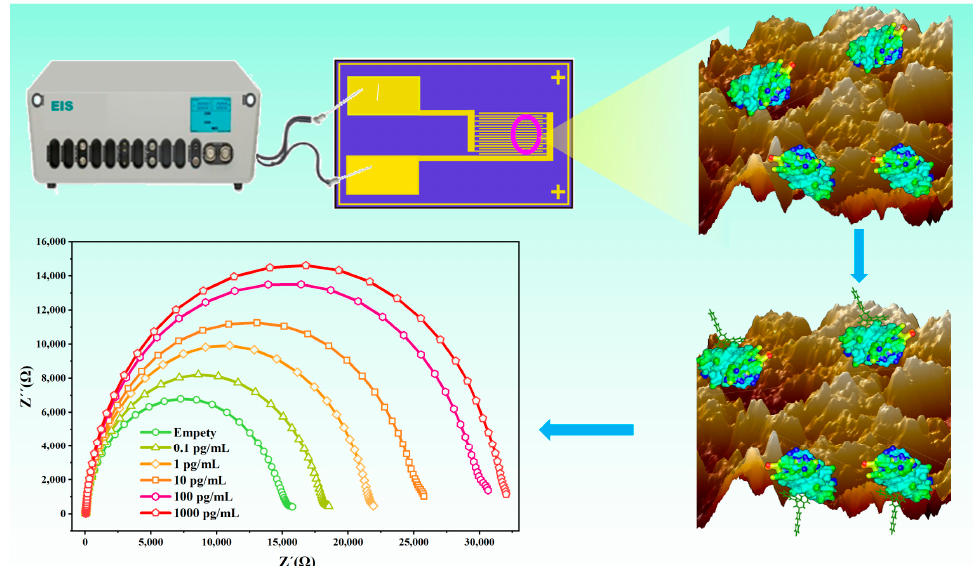
Figure 1. Schematic diagram of ultrasensitive detection of DIF (3-(3-biphenyl-4-yl-1,2,3,4-tetrahydro-l-naphthyl)-4-hydroxycoumarin). The Nb AR-H2-1 was applied to modified on the surface of the electrode to constructed a bioimpedance sensor. Then, DIF solutions were added to the working area of the electrode. After DIF completely reacted with Nbs, [Fe(CN)6] 3 − /4 − (2.0 mM) was added, and the electrochemical impedance were measured on the electrochemical workstation.